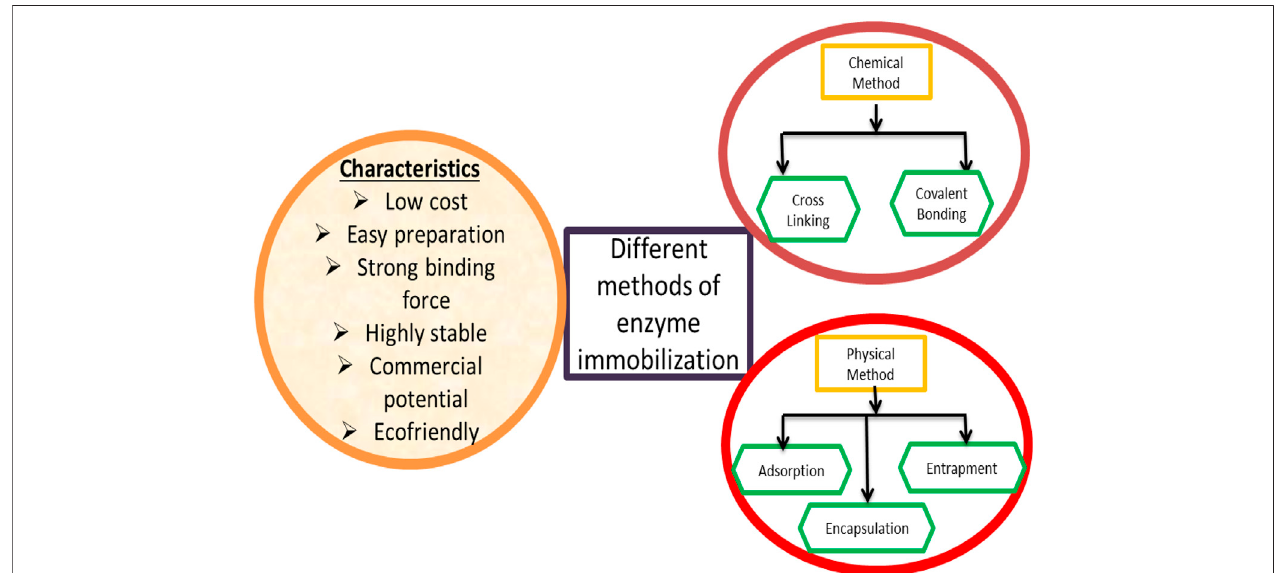
FIGURE 1 | Chemical and physical method(s) of immobilization and their